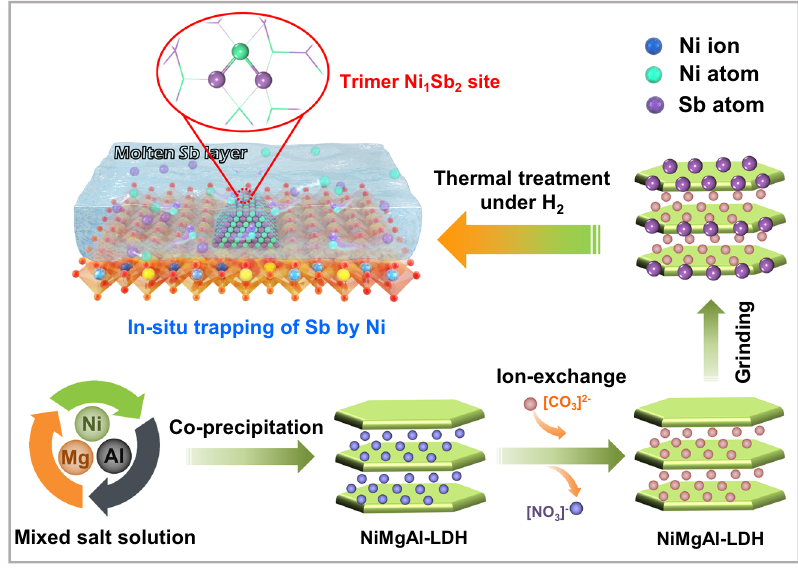
Fig. 2 | Synthesis strategy for Ni 1 Sb 2 sites. Schematic illustration for the con- struction of the trimer Ni 1 Sb 2 site in the NiSb intermetallic structure via an in situ